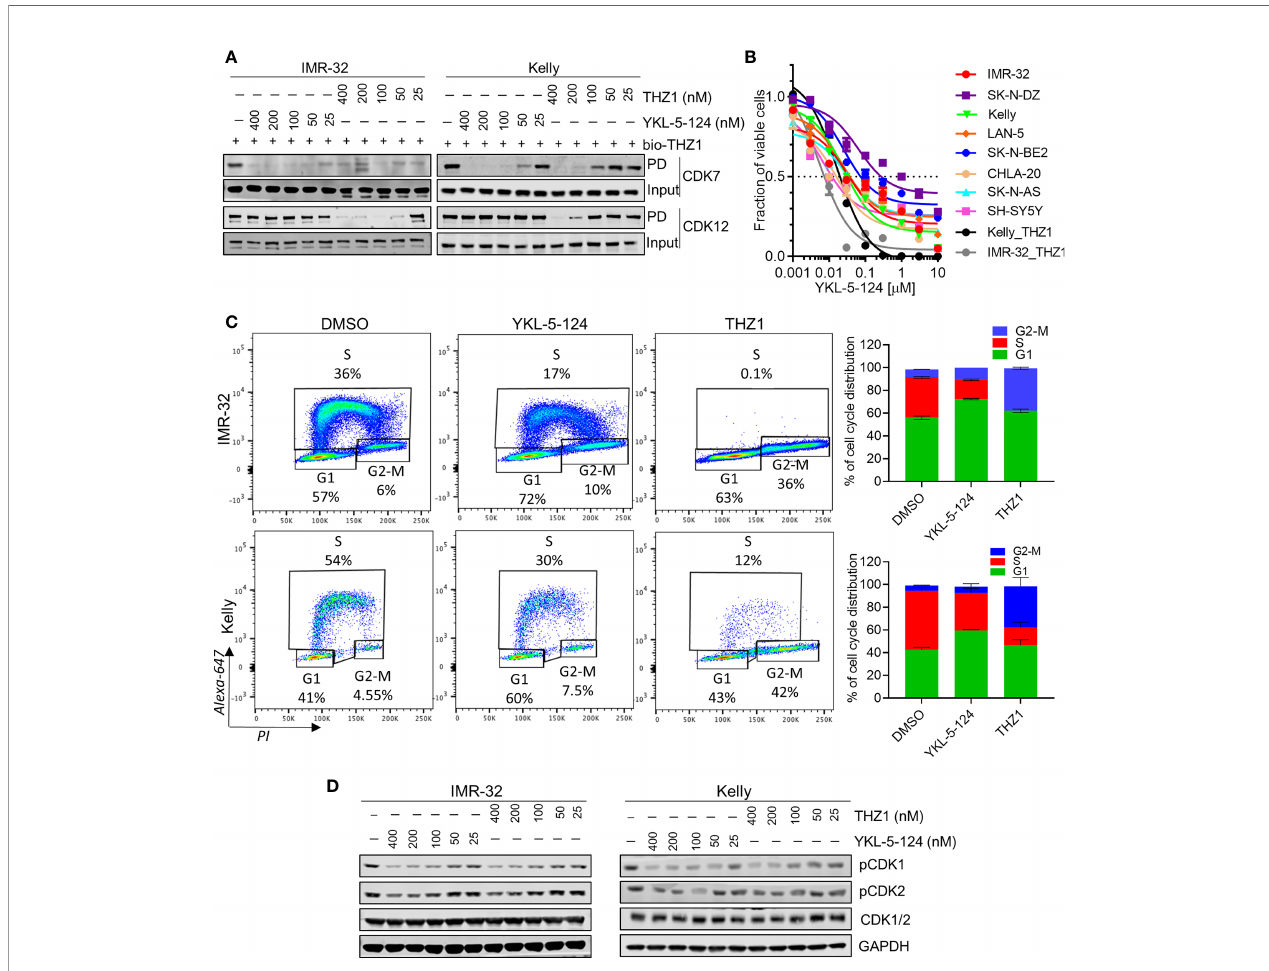
FIGURE 1 | Selective CDK7 inhibition with YKL-5-124 leads to aberrant cell cycle progression in NB cells. (A) Analysis of target engagement in NB cells following THZ1 or YKL-5-124 treatment. Cells were treated with THZ1, YKL-5-124 or DMSO for 6 h at the indicated doses and cell lysates were incubated with 1 m M of biotinylated THZ1 (bio-THZ1) overnight. Western blot (WB) analysis of CDK7 and CDK12 in the immunoprecipitate (PD). (B) Dose-response curves for NB cells treated with increasing concentrations of YKL-5-124 or THZ1 for 72h. Cytotoxicity is reported as percent cell viability relative to DMSO-treated cells. Data represent mean±SD; n =3. (C) Flow cytometry analysis of EdU staining in NB cells treated with 100 nM THZ1, 100 nM YKL-5-124 or DMSO for 24 h (left). The percentages of living cells in each phase of the cell cycle are shown. Quanti fi cation of staining (right), data represents mean±SD; n =3. (D) WB analysis of pCDK1 (Thr161), pCDK2 (Thr160) and total CDK1/2 in NB cells treated with YKL-5-124 or THZ1 at indicated doses for 6